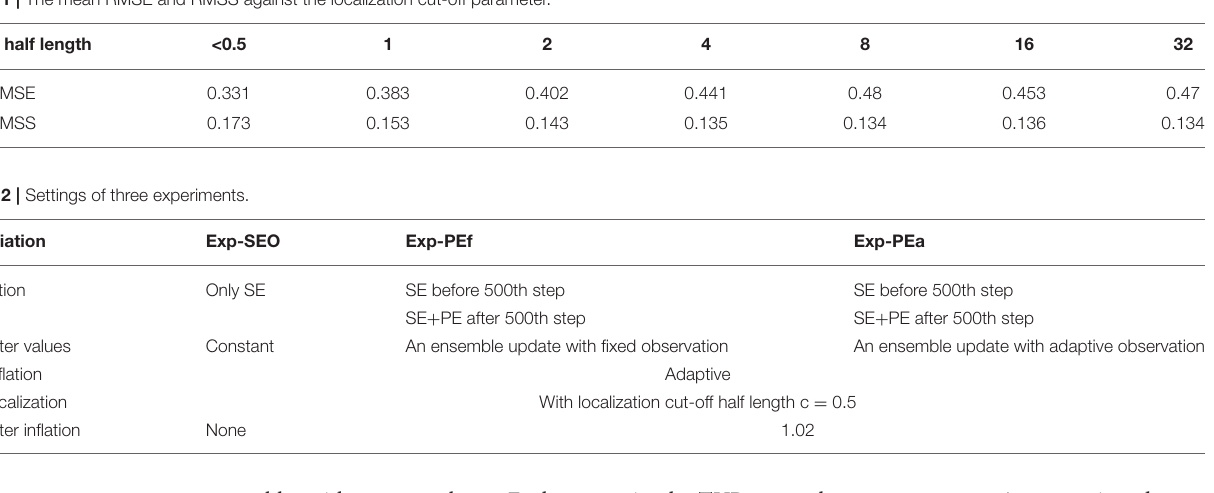
TABLE 1 | The mean RMSE and RMSS against the localization cut-off parameter.